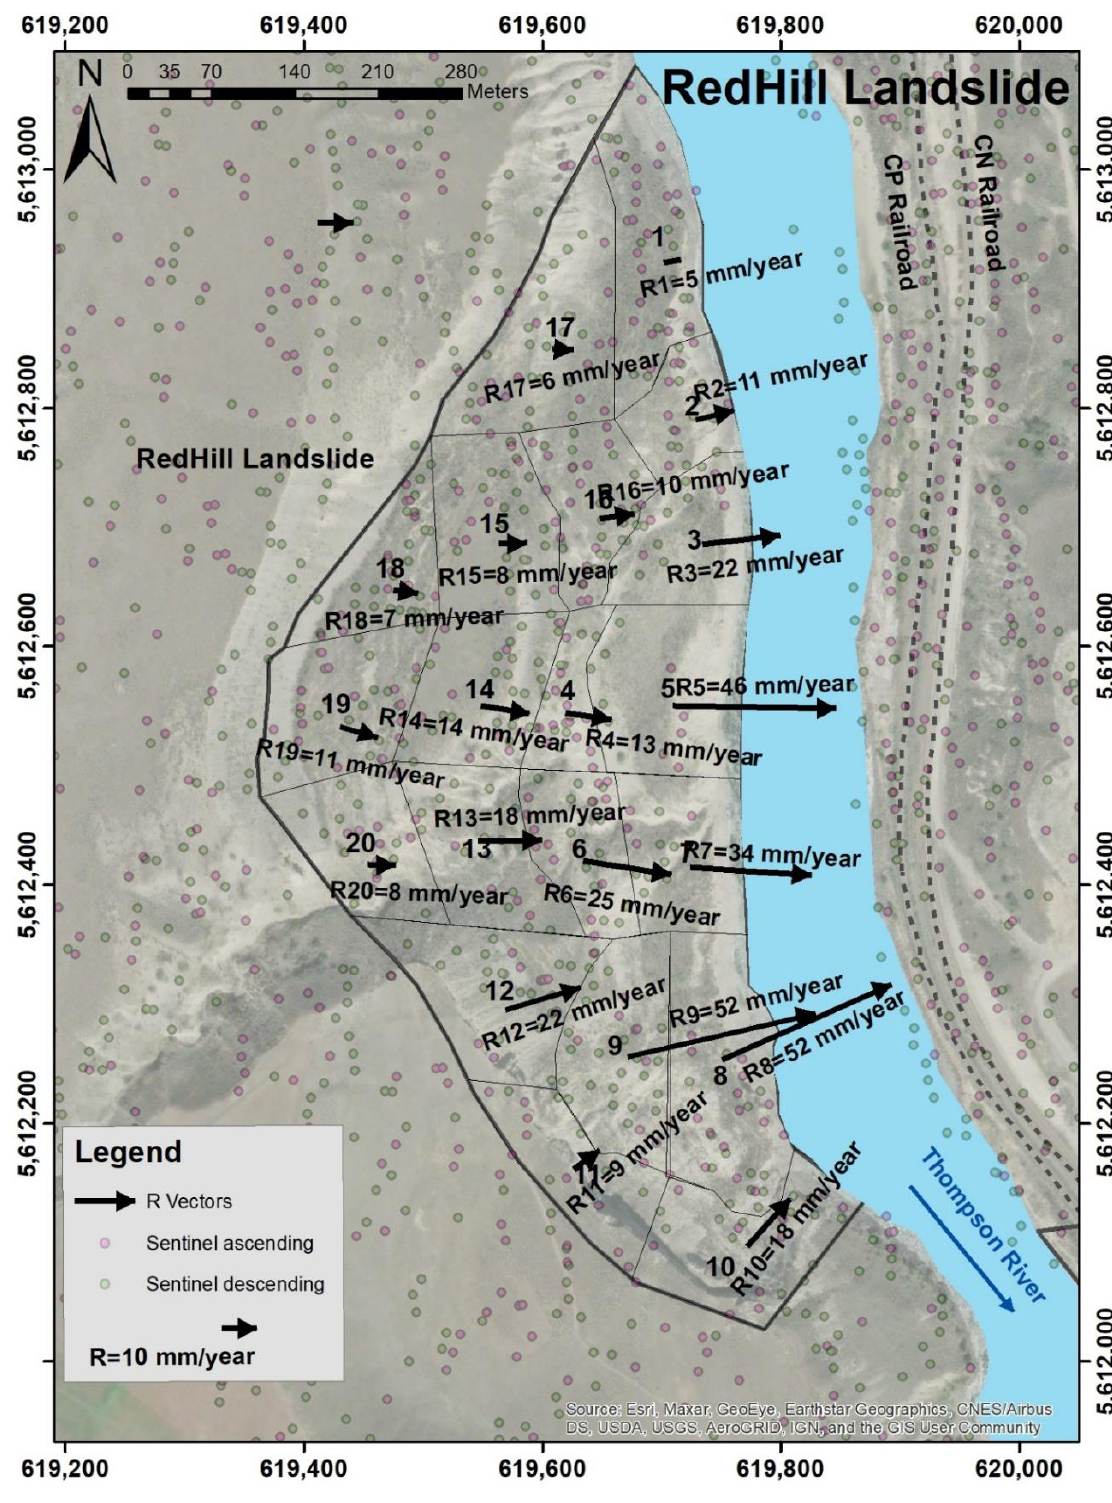
Figure 26. Calculated horizontal component of R on the Redhill landslide. The vertical components of R for selected sectors of the landslide are shown in Figure 27. This figure shows that ground displacements have a significant vertical compo- nent regardless of the distance from the toe or the back scarp, transitioning towards fewer vertical components near the toe. This would indicate that the toe of the landslide is likely well into the riverbed that could not be captured by the Satellite InSAR data